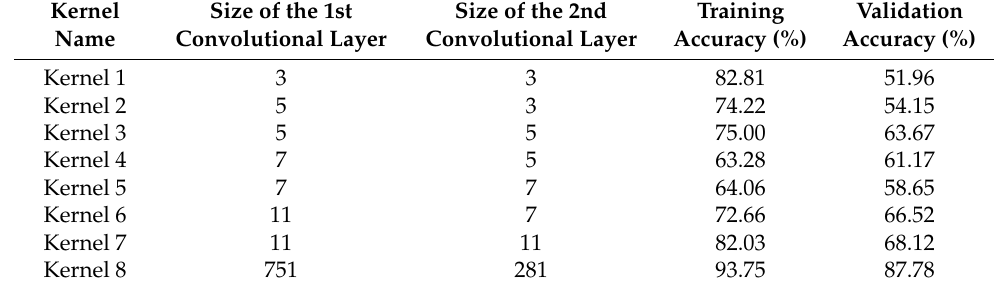
Table 5. Training and validation loss of commonly used kernel sizes and the proposed kernel size.